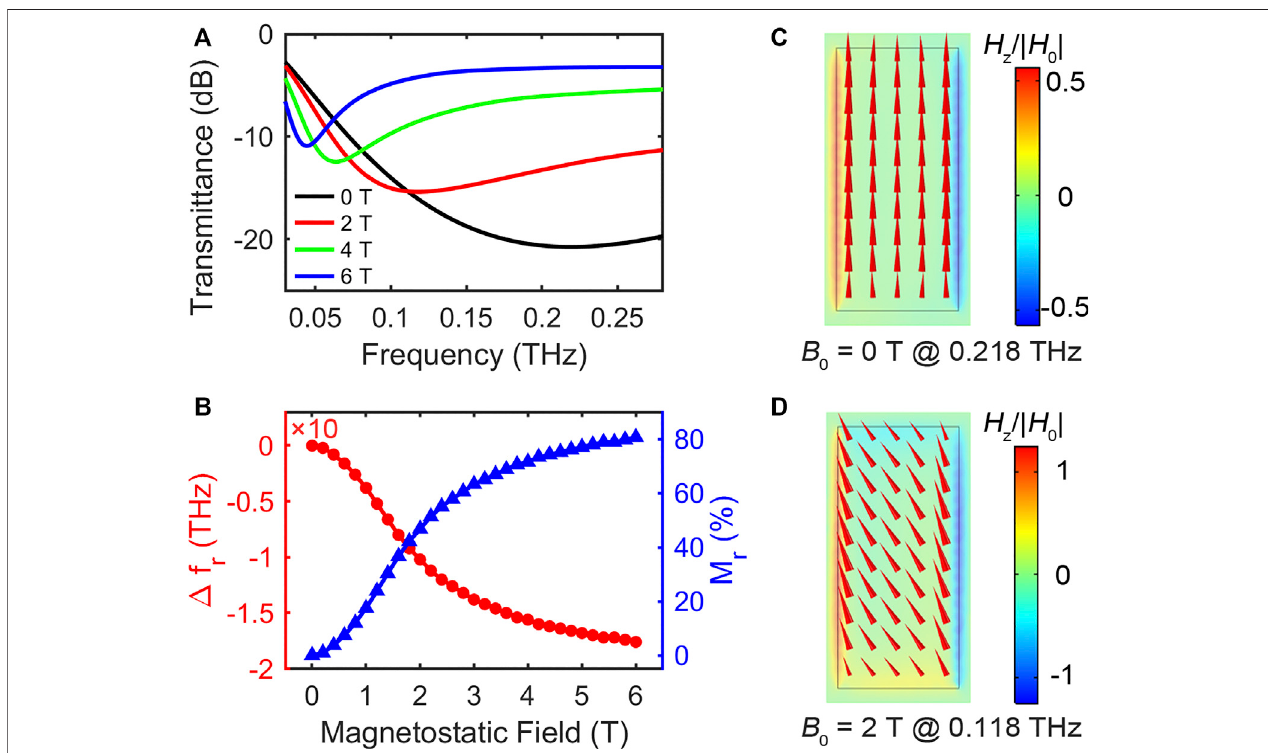
FIGURE 2 | (A) The transmittance spectra of the graphene THz metasurface under different external uniform magnetic fl ux densities applied. (B) The resonance frequency shifts and the frequency modulation index M f as functions of the values of applied magnetic fl ux density. The normalized magnetic fi eld H z / H 0 ( H 0 is the magnetic fi eld amplitude of the incident THz wave) and surface currents distributions of the cut-wire resonator at resonant frequencies (C) without ( B 0 (cid:2) 0 T) or (D) with ( B 0 (cid:2) 2 T) the magnetostatic fi eld applied in the direction perpendicular to the graphene THz metasurface.